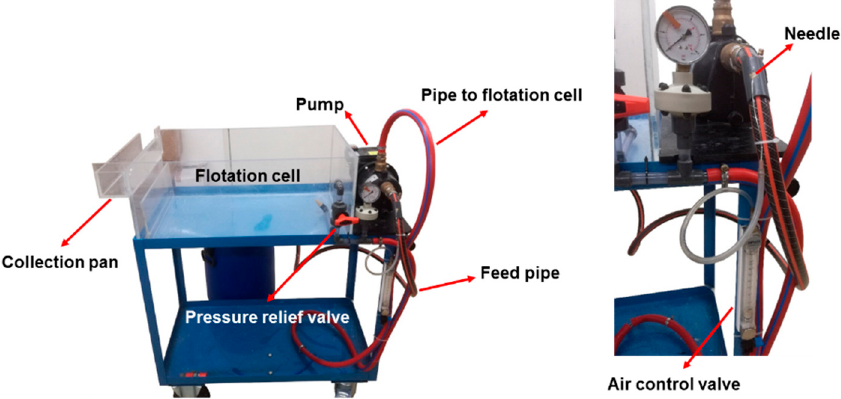
Figure 2. Flotation cell for thickening of fines (left); magnification of the air injection system.